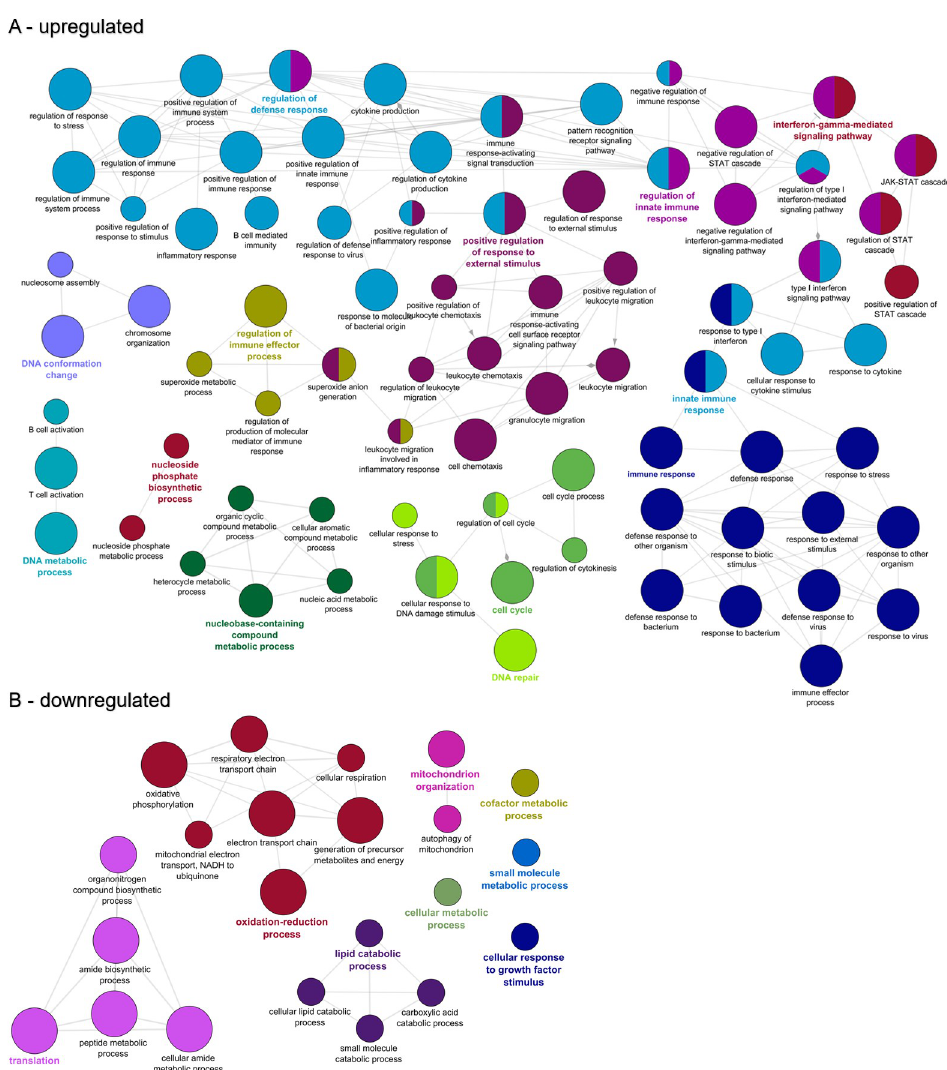
Fig 7. Functional enrichment of biological processes among the genes differentially expressed in the intestine of susceptible fish at 14 days post exposure to Ceratonova shasta . Enriched gene ontology (GO) terms were grouped into functionally related nodes using the Cytoscope plugin ClueGO. Nodes are colored and grouped according to a related function and labelled by the most significant term of the group. Node size corresponds to the FDR-adjusted p- value of each GO term and is specific to each graph. The analysis was conducted separately on upregulated (A) and downregulated (B) genes.